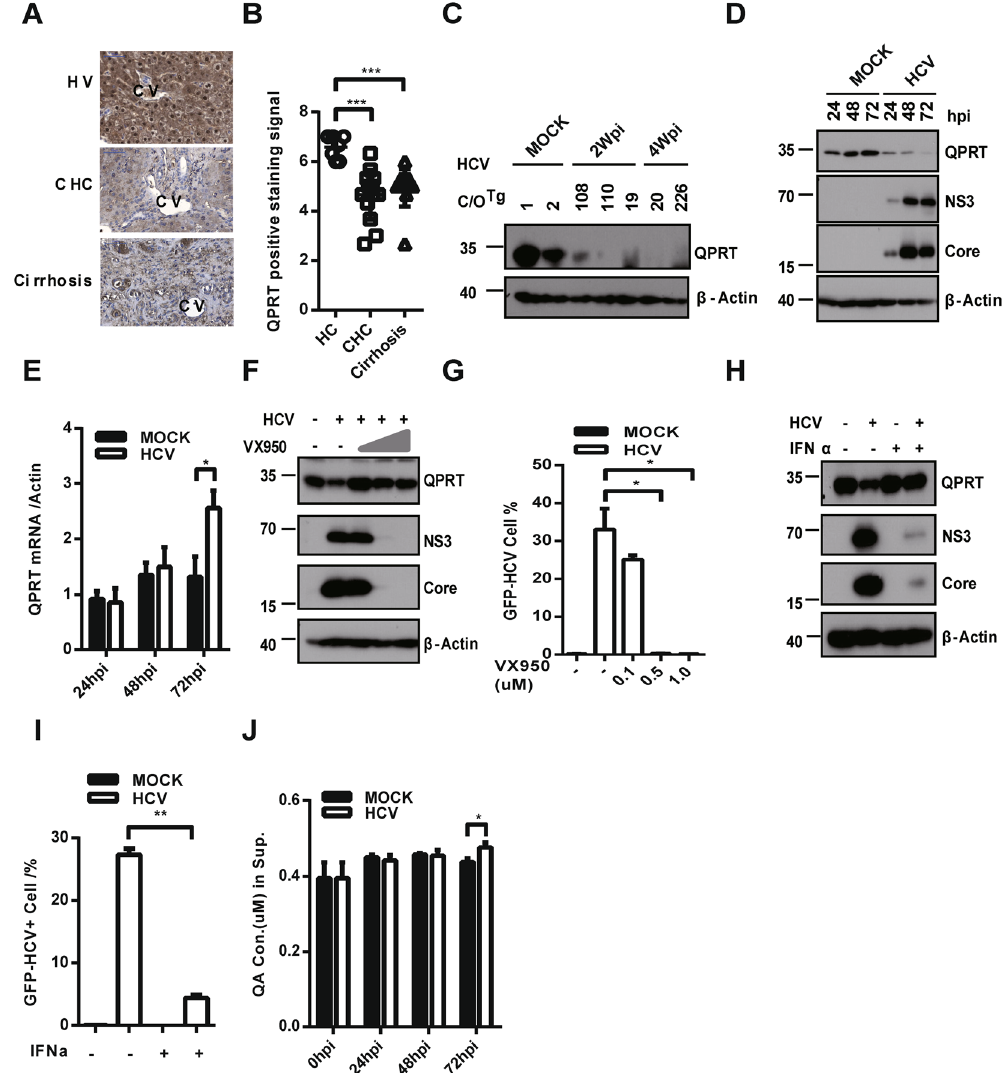
Figure 1. HCV infection reduced QPRT expression and NAD catabolism. ( A ) IHC staining of QPRT (dark brown) was performed and ( B ) the scores of QPRT positive areas were scored on liver biopsies of healthy donor (HV), chronic HCV infection (CHC) and HCV induced cirrhosis (Cirrhosis). cv, central vein, scale bars, 50 μ m. ( C ) Expression levels of hepatic QPRT were measured by immunoblotting after C/O Tg mice were mock infected or infected with HCV J339EM for 2 (#19, 108, 110) and 4 weeks (#20, 226). β -actin was used as a loading control. ( D ) Decay of QPRT was assessed by immunoblotting after Huh7.5.1 cells were mock or infected with HCV for indicated time. HCV NS3 and Core proteins were detected by immunoblotting for HCV replication. ( E ) QPRT mRNA was detected by qRT-PCR and plotted as the ratio to actin. After Huh7.5.1 cells were infected with HCV for 6 h, the increasing concentration of VX950 ( F–G ) or 1000 U/mL IFN α -2b ( H–I ) was added for 48 h. Cells were detached and ( F,H ) detected by immunoblotting for QPRT, NS3 and Core proteins, and ( G,I ) FACS measured for GFP positivity. ( J ) Huh7.5.1 cells were infected with HCV J399EM for indicated time, and extracellular QA was analyzed by LC-MS/MS. Full-length gels and blots are included in the Figure S5. Error bars were SEM of three independent experiments, student t test, * P < 0.05; ** P < 0.01, *** P <